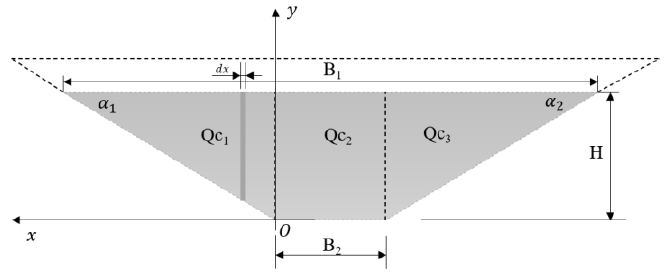
Figure 6. The longitudinal section of the core.